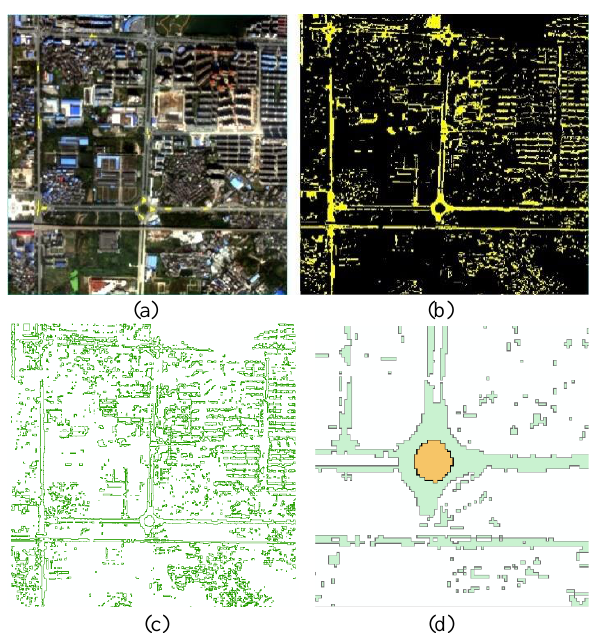
Figure 5. Road classification and hole detection. (a) ROI collection in bright yellow. (b) SVM classification. (c) Convert road polygon to lines. (d) Successful hole detection and generation, the orange polygon is the hole.